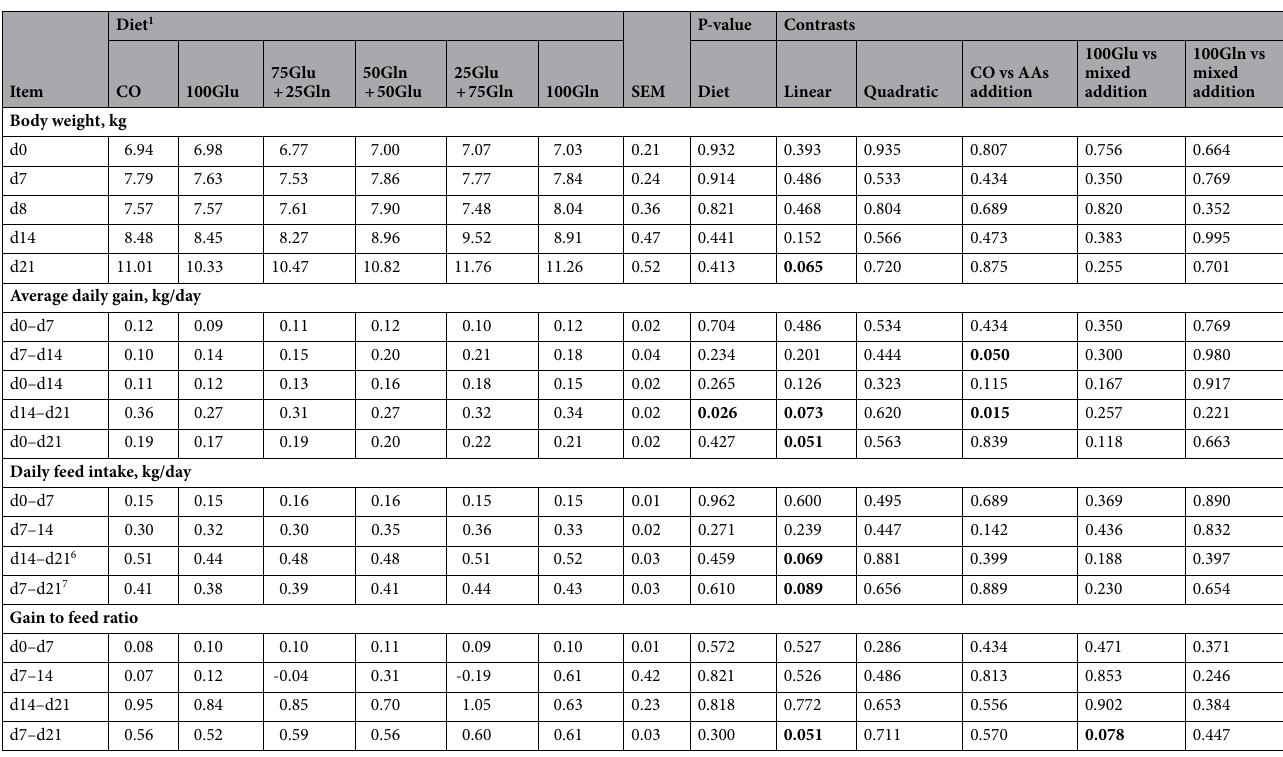
Table 1. Effect of the dietary supplementation (6 kg/T) with glutamate and glutamine in different ratio on growth performance of post-weaning piglets. Diet 1 CO = standard diet; 100Glu = CO plus 6 kg/Ton Glu; 75Glu + 25Gln = CO plus 4.5 kg/Ton Glu and 1.5 kg/Ton Gln; 50Glu + 50Gln = CO plus 3 kg/Ton Glu plus 3 kg/Ton Gln; 25Glu + 75Gln = CO plus 1.5 kg/Ton Glu and 4.5 kg/Ton Gln; 100Gln = CO plus 6 kg/Ton Gln. Significant values are in